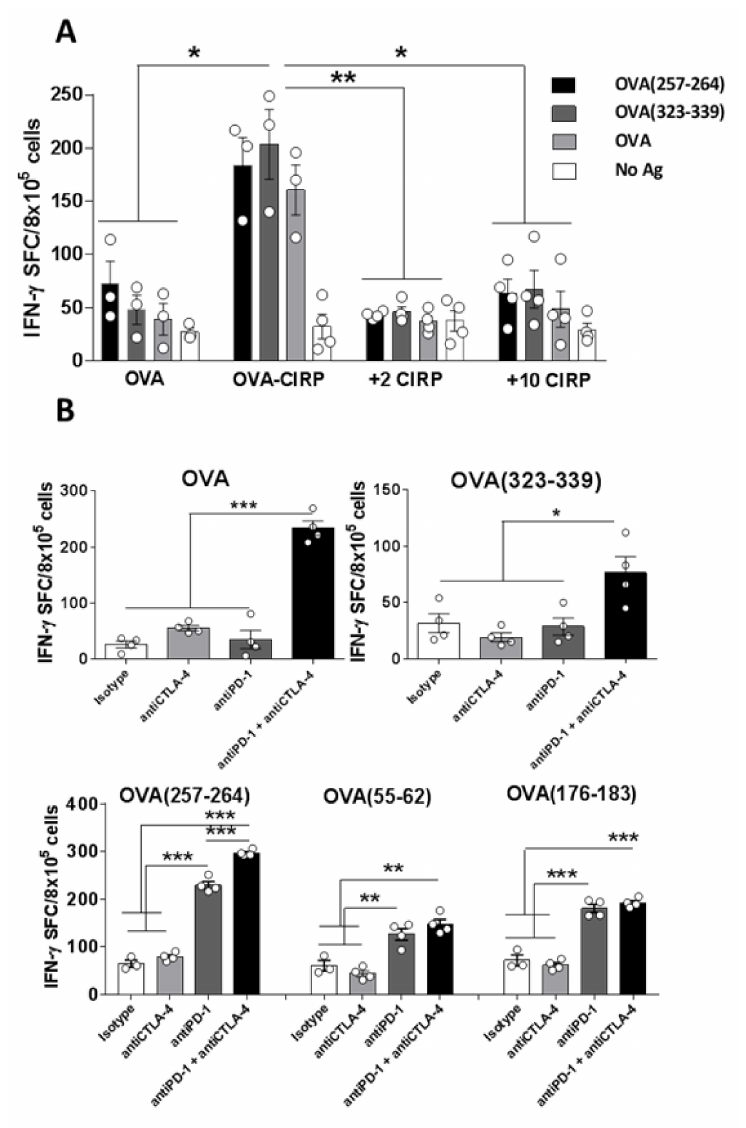
Figure 1. Conjugation of ovalbumin (OVA) to the CIRP platform induces polyepitopic T-cell responses that are enhanced by combination with immune checkpoint inhibitors (ICPI). ( A ) C57BL6 / J